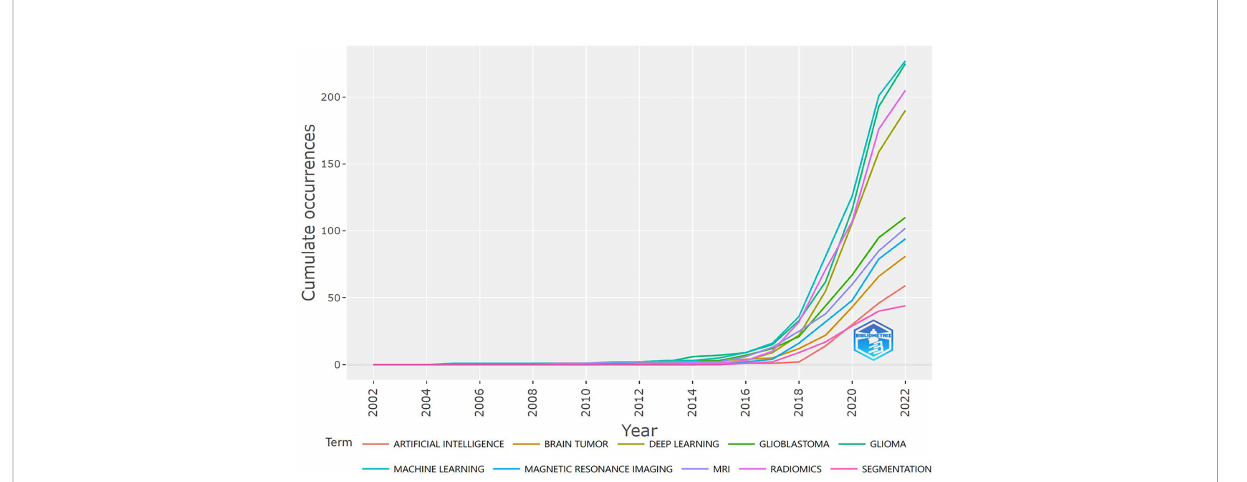
FIGURE 6 The horizontal axis represents the year. The vertical axis represents the cumulative occurrence of different terms. Different colors represent different terms.